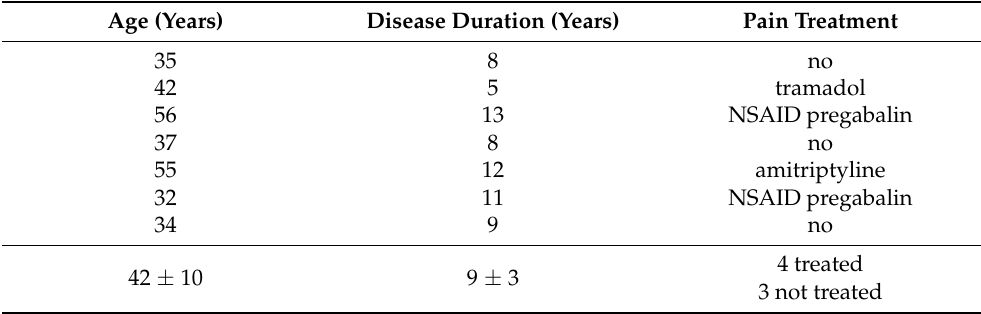
Table 1. Patients’ characteristics. Data are reported as mean with standard deviation or count. Legend: NSAID: non-steroidal anti-inflammatory